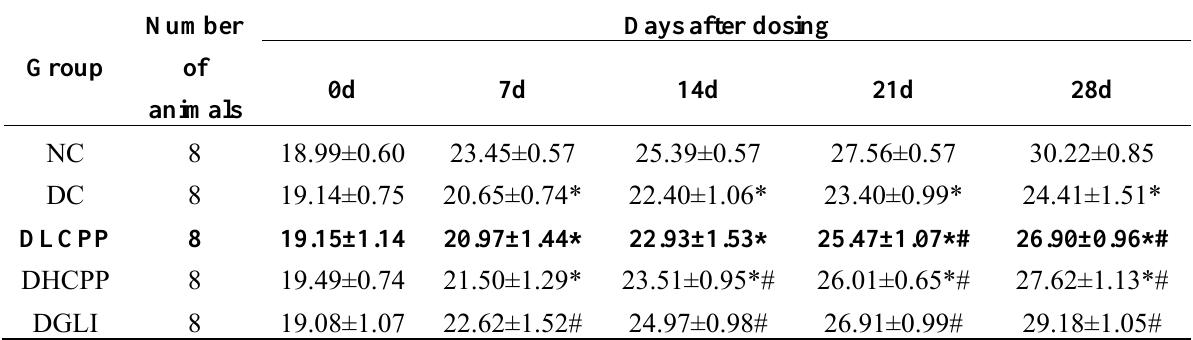
Table 1. Effect of CPP on body weight (g) in